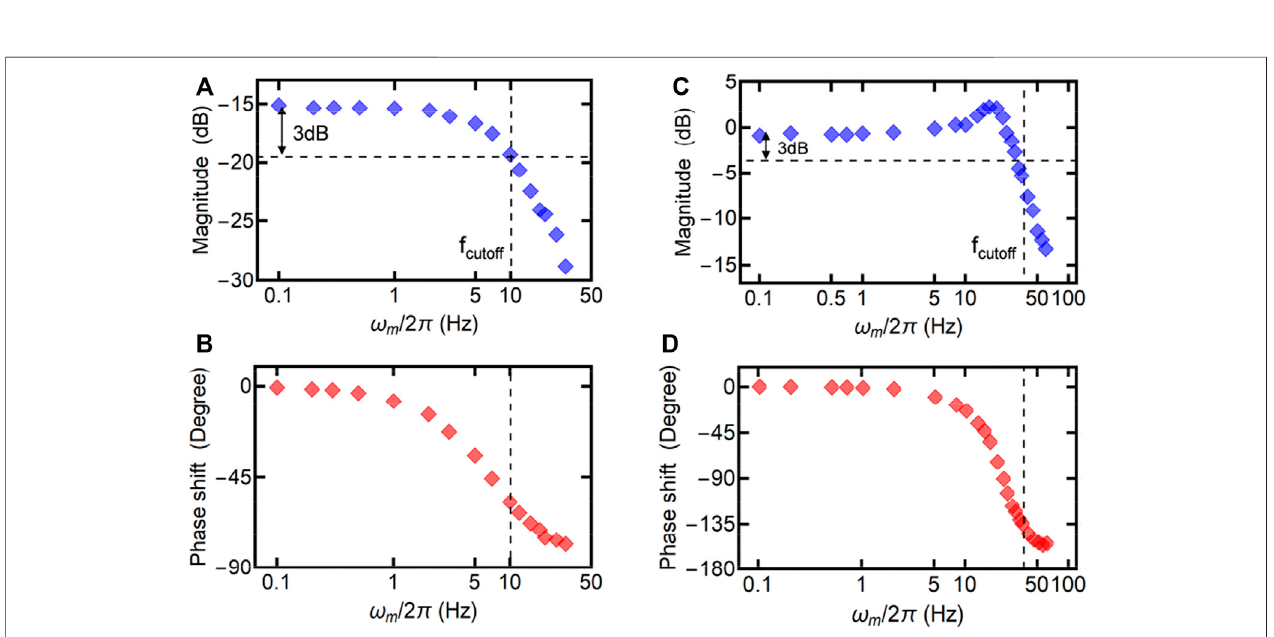
FIGURE5|(A,B) Themeasured magnitudeandphaseshiftoftheresponsefunctionR 1 asafunctionof ω m intheweakcouplingregime( Λ = ‒ 2 π ×1 Hz). (C,D) The measured magnitude and phase shift of the response function R 1 as a function of ω m in the strong coupling regime ( Λ = ‒ 2 π ×15 Hz). The dashed lines are used to indicate the cutoff frequency. Other experimental parameters are the same as in Figure 4